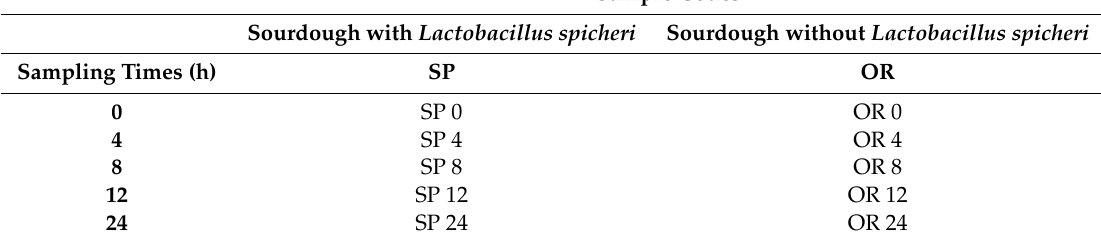
Table 2. Samples codification and sampling times during sourdough fermentation with Lactobacillus spicheri DSM 15429 (Lsp) and without